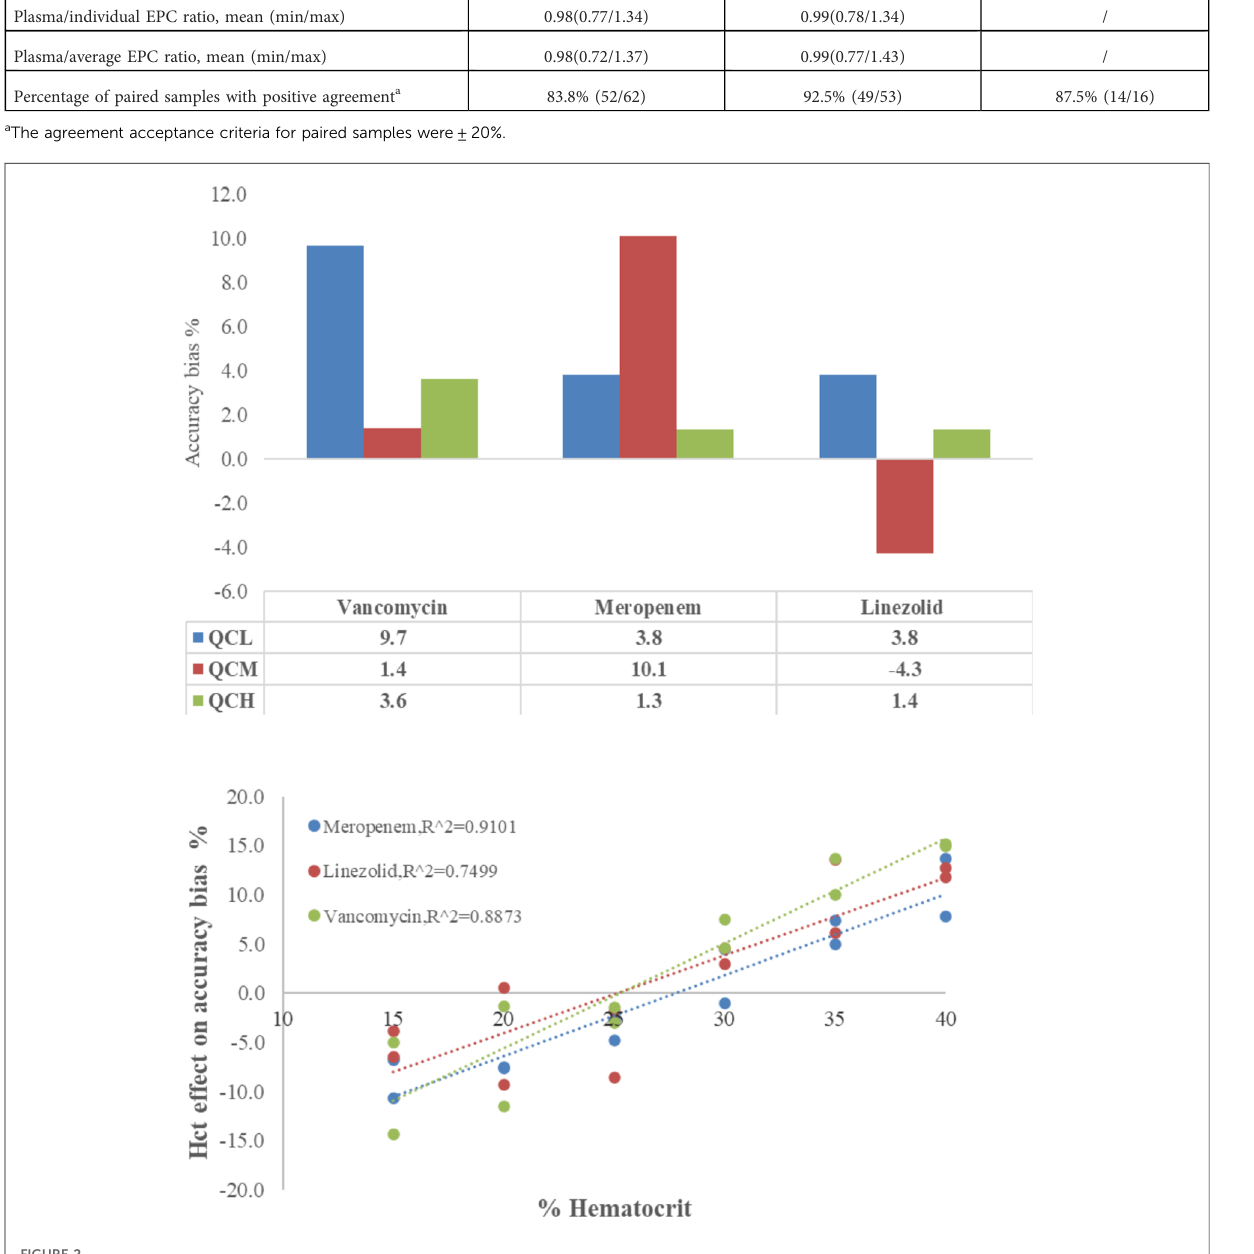
FIGURE 2 Accuracy of vancomycin, meropenem, and linezolid in capillary microsamples and DBS samples — upper: adsorption test on the capillary tube, lower: the Hct effect on